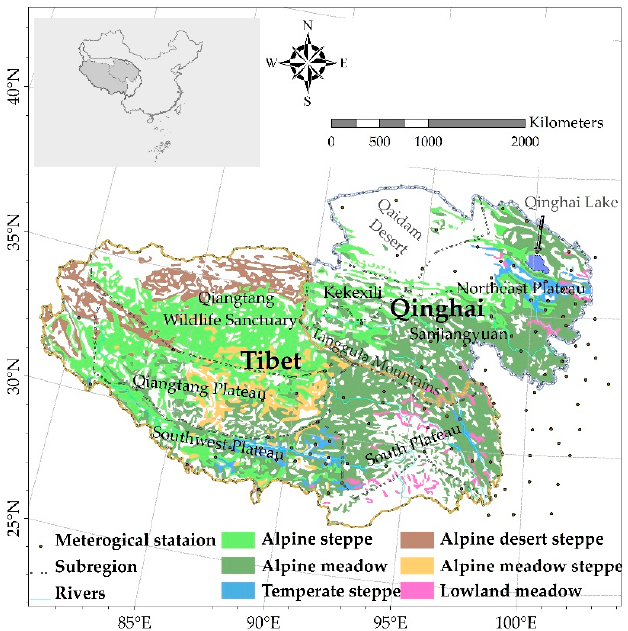
Figure 1. The study region and meteorological stations for different grassland types.